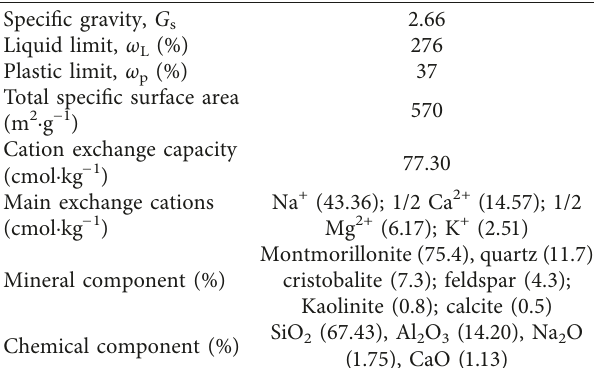
Table 2: Basic properties of GMZ